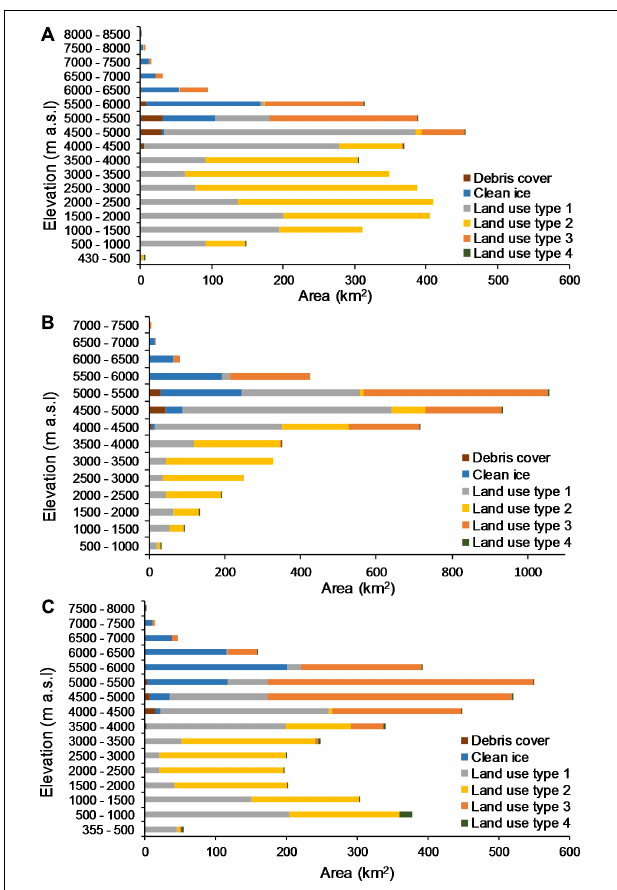
FIGURE 2 | Area-altitude distribution of debris-covered and clean ice along with other land use types in (A) Tamor, (B) Trishuli, and (C) Marsyangdi River basins based on the ASTER GDEM of 30 m resolution, GlobeLand30 and ICIMOD Glacier Inventory (2010).